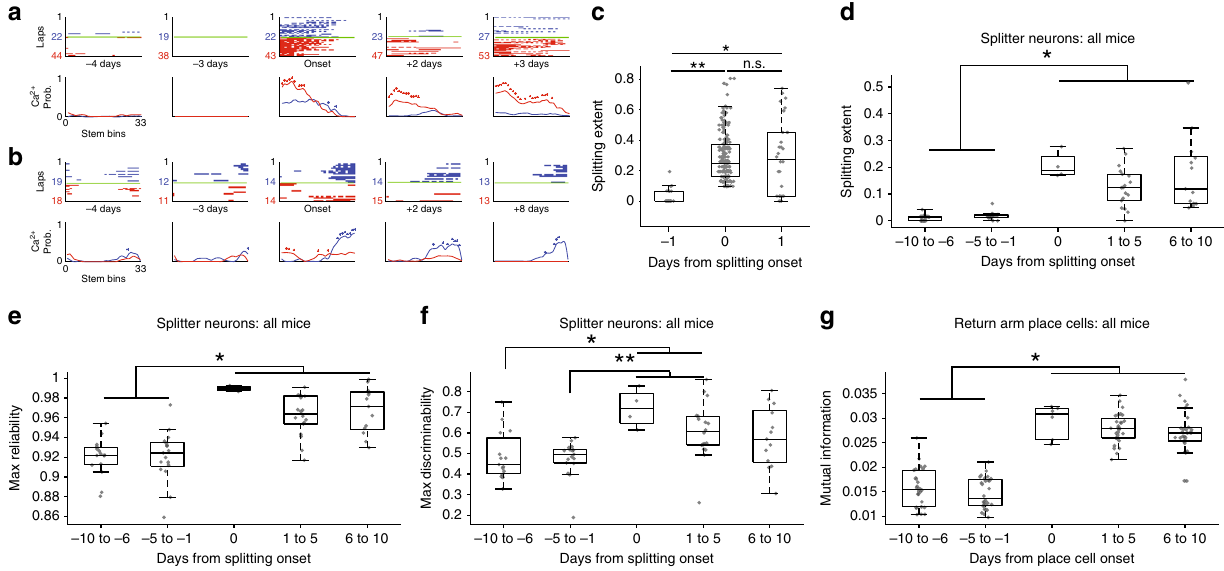
Fig. 6 Splitters come online abruptly and maintain stable fi elds. a , b Example splitter across days for two different mice illustrating sudden onset of trajectory-dependent activity followed by stable trajectory-dependent activity thereafter. c Splitting extent (proportion of stem bins with signi fi cant trajectory-dependent activity) along the stem±1 days from splitter onset for one representative mouse. p = 1.8 × 10 − 10 Kruskal – Wallis ANOVA, N = 233 neurons, * p = 1.2 × 10 − 5 , ** p = 1.0 × 10 − 9 two-sided post-hoc Tukey test. Gray circles = splitting extent for each neuron. Box plots show median and 1st/ 3rd quartiles, whiskers extend to 1.5× interquartile range. d Extent of splitting±10 days from splitter onset for all mice. p = 2.5 × 10 − 9 Kruskal – Wallis ANOVA, N = 67 means, * p < 6.2 × 10 − 3 two-sided post-hoc Tukey test. Gray circles = mean splitting extent for each mouse of all neurons active on the stem across all session-pairs. Box plots show median and 1st/3rd quartiles, whiskers extend to 1.5x interquartile range, same conventions used in ( e – g ). e Max reliability score±10 days from splitter onset for all mice. p = 4.4 × 10 − 8 Kruskal – Wallis ANOVA, N = 67 means, * p < 1.6 × 10 − 3 two-sided post-hoc Tukey test. f Peak discriminability score±10 days from splitter onset for all mice. p = 3.4 × 10 − 4 Kruskal – Wallis ANOVA, N = 67 means, * p < 0.016, ** p < 0.018 two-sided post-hoc Tukey test. g Mean mutual information±10 days from return place cell onset for all mice. p = 3.0 × 10 − 11 Kruskal – Wallis ANOVA, N